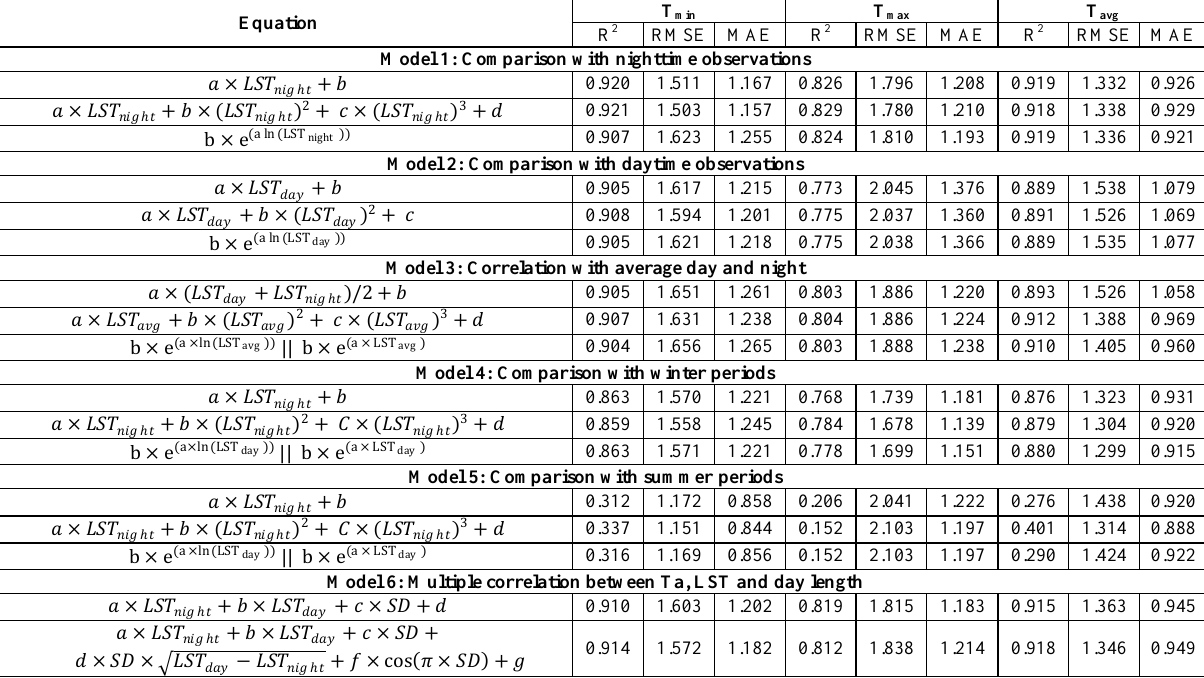
Table 3. Model equations and accuracy validation of minimum, average and maximum air temperature (a, b, c, d, f and g are